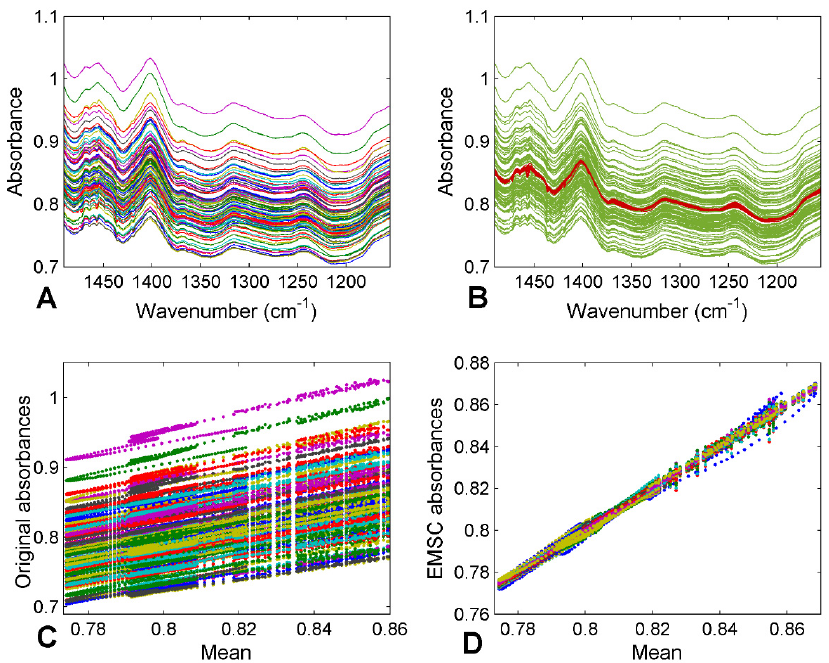
Figure 1. FTIR spectra of plasma samples before ( A ) and after ( B ) EMSC pre-treatment, and the corresponding plots of scattering effects between signals before ( C ) and after ( D ) correction.